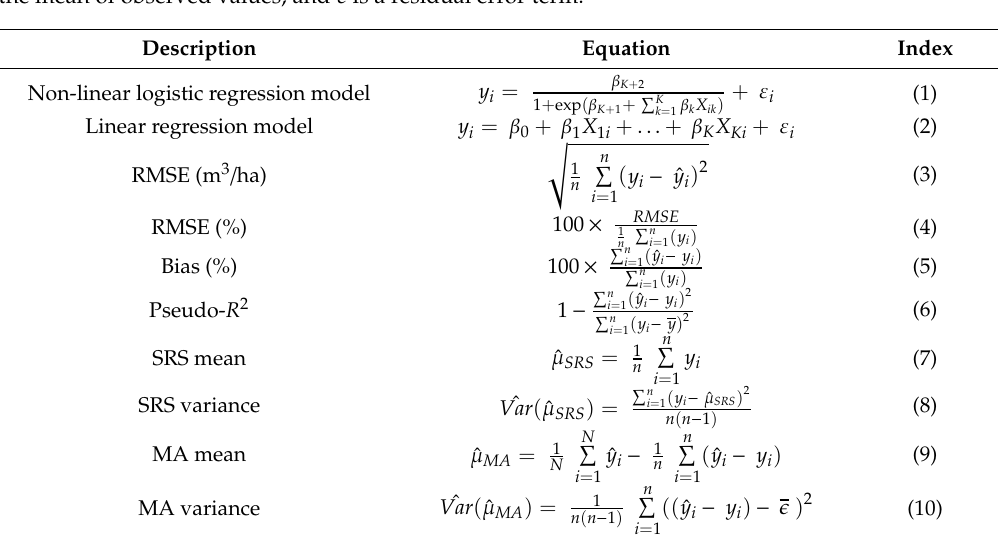
Table 1. Equations for regression models, Root Mean Square Error (RMSE), RMSE%, bias%, and Pseudo- R 2 , and simple random sampling (SRS) and model assisted (MA) statistics. In each equation, i indexes sample plots, X ik is the k th predictor, β are model parameters, ˆy i and y i represent predicted and observed timber volume for sample plot i , respectively, and n is the number of samples; ¯у represents the mean of observed values, and ε is a residual error